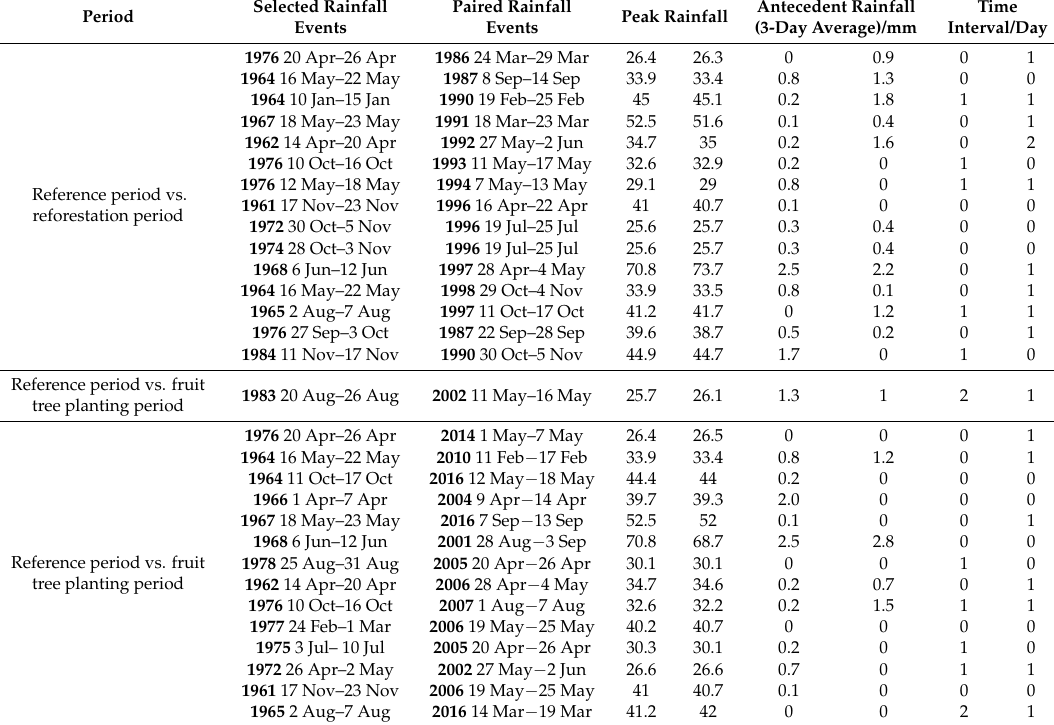
Table A4. The pairs of rainfall events in the Jiujushui